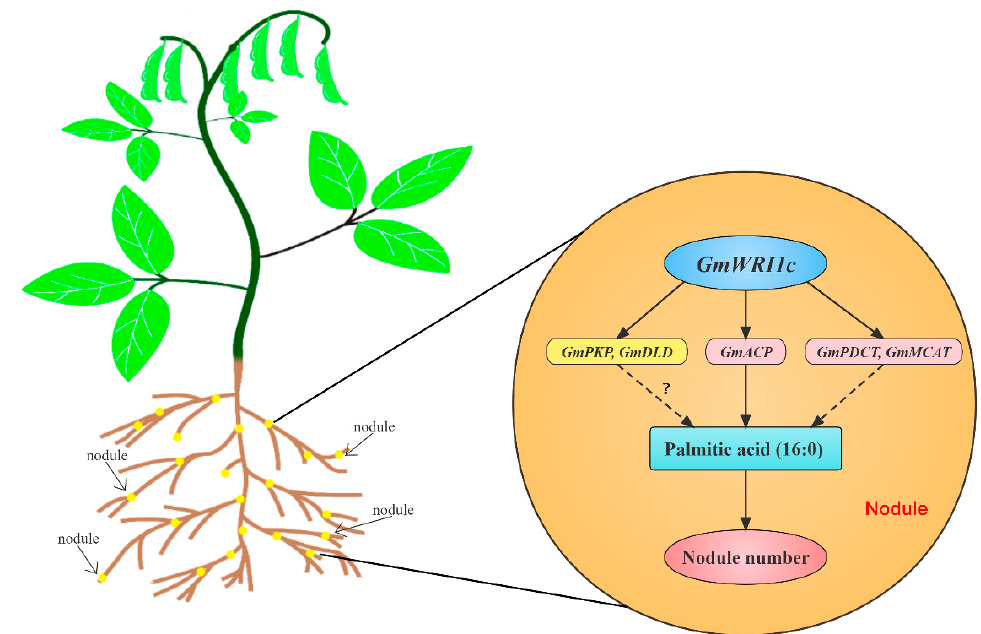
Figure 6. A working model for GmWRI1c regulation of soybean nodulation. ?—The mechanism of GmPKP and GmDLD increase palmitic acid is unclear.